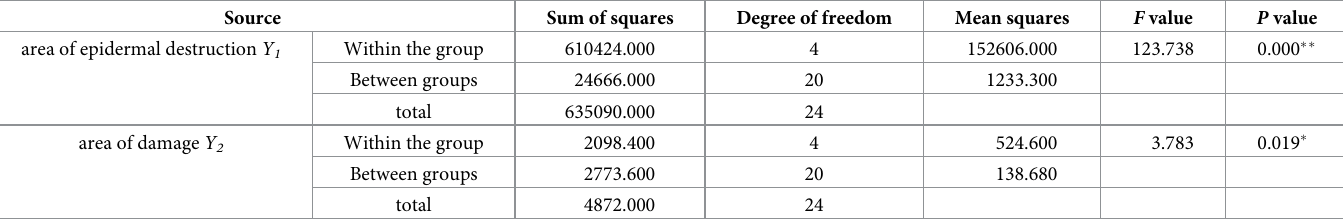
Table 5. Variance analysis of the influence of sweet potato falling height on various indexes.